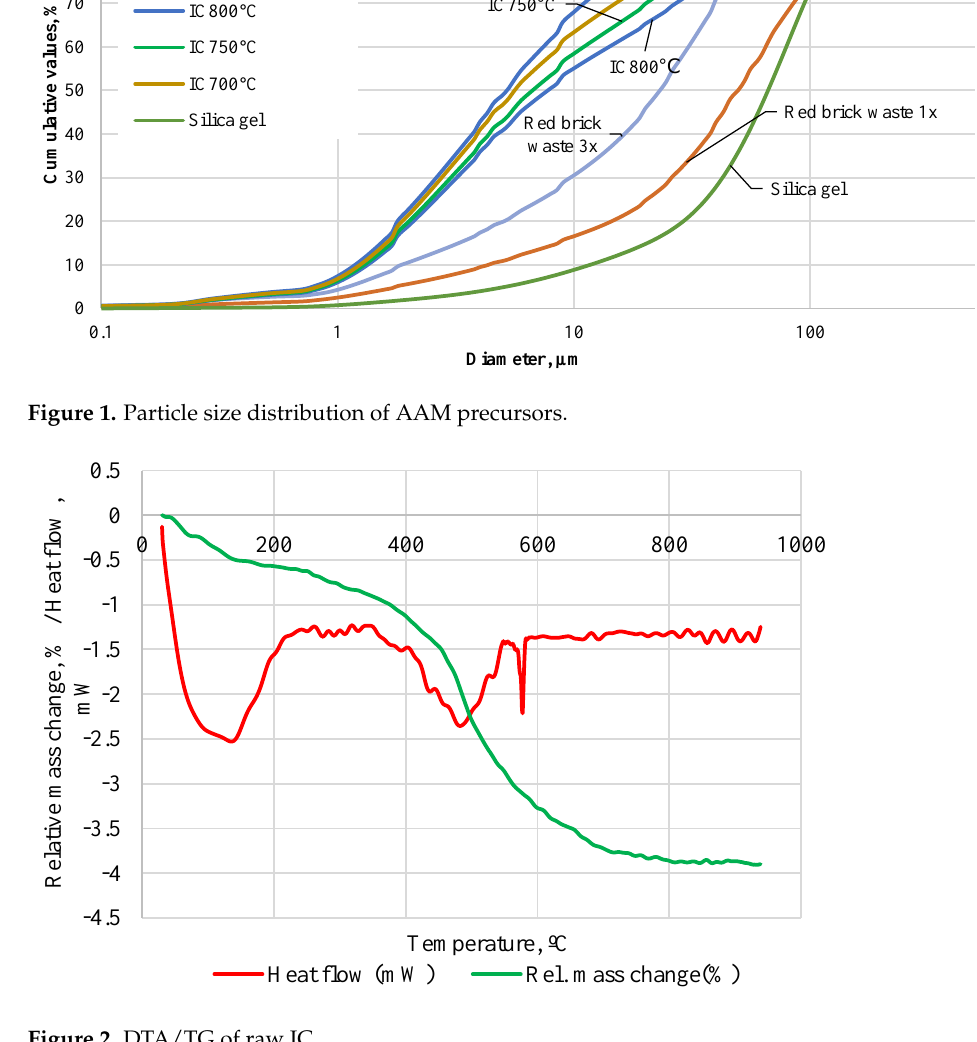
Figure 1. Particle size distribution of AAM precursors.